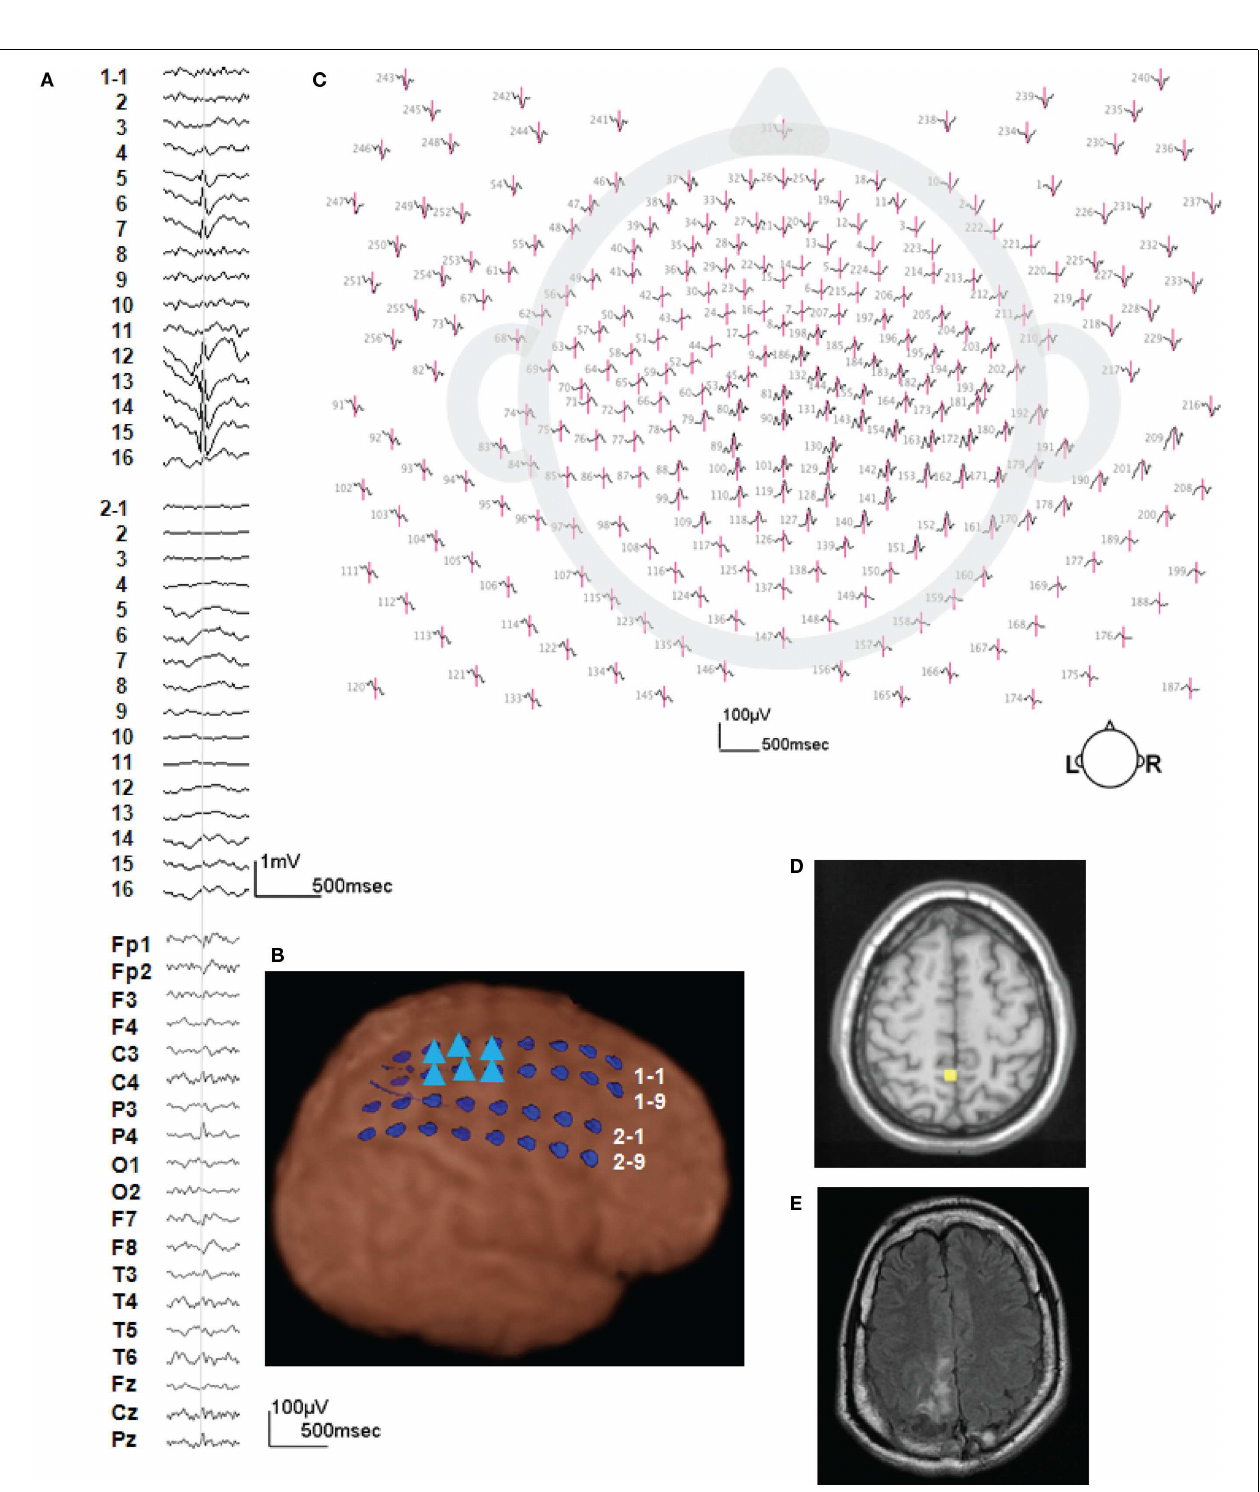
interictal spike. (C) Two hundred fifty-six-channel dEEG topographic plot of the corresponding spike.The view is looking down on top of the head with nose at the top.The 256-channnel topographic plot was instructive in localizing the spike to the right parietal lobe. (D) The source estimation by dEEG superimposed on a standard MRI.The interictal spike is localized to right parietal head region. (E) Post-operative